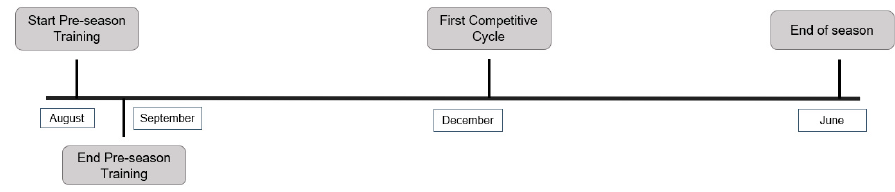
Figure 1. Data Collection